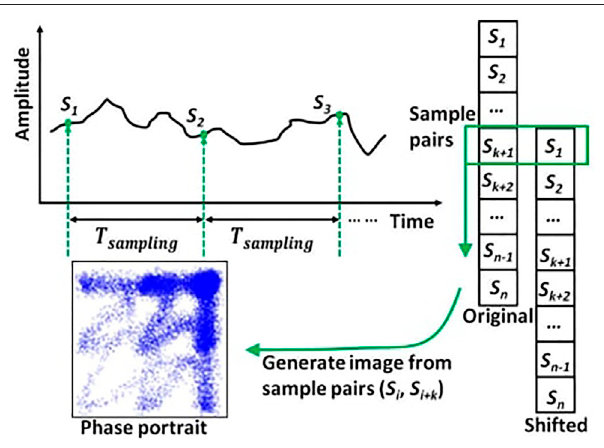
FIGURE 8 | Generation of a phase portrait from ASCS (Fan et al.,